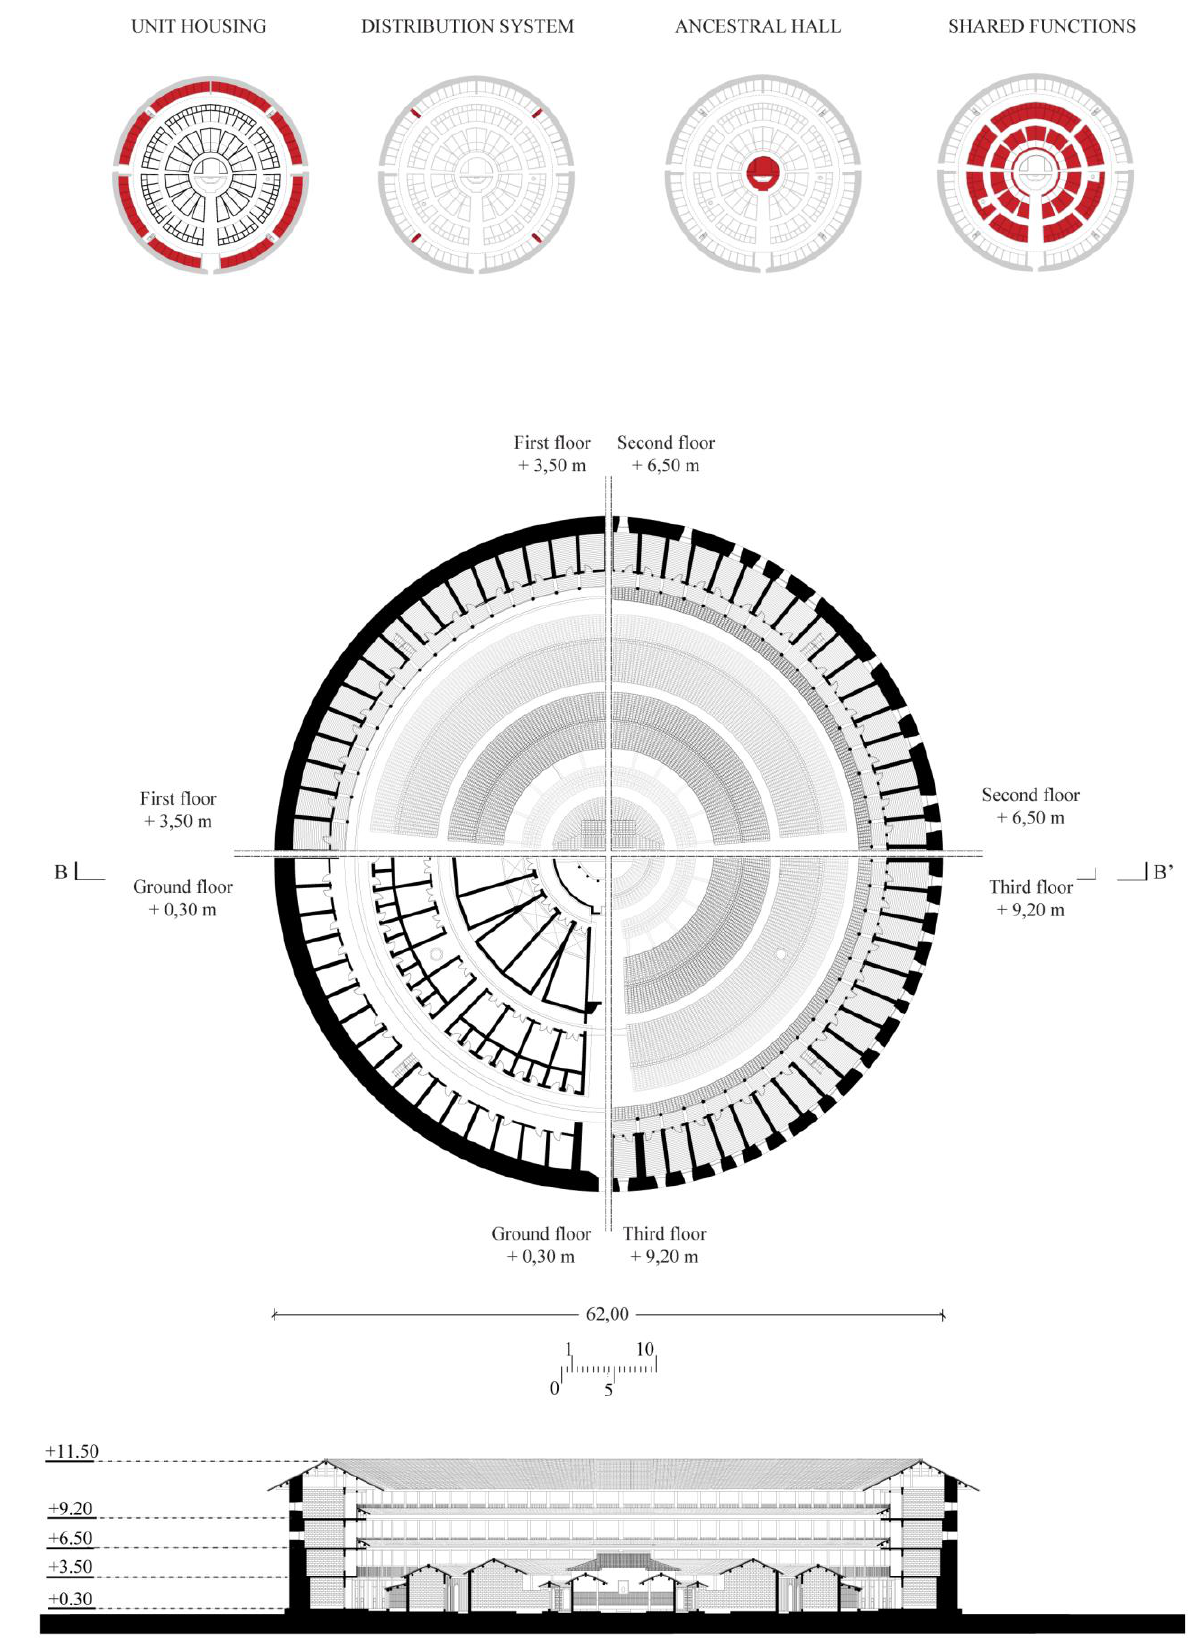
Figure 5. Case study Chengqi Lou, 1628-1644, Gaobei settlement, Yongding County (Hakka Tulou, gallery